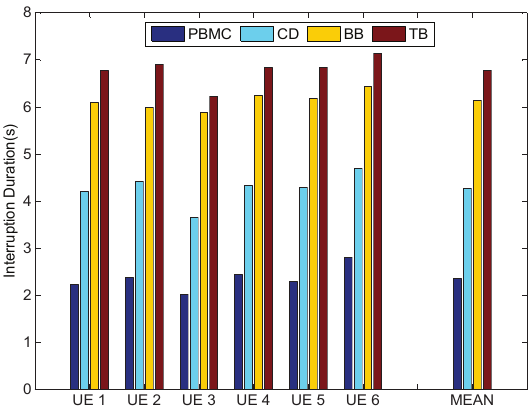
Figure 4: Interruption Duration for the six users under each adaptation scheme